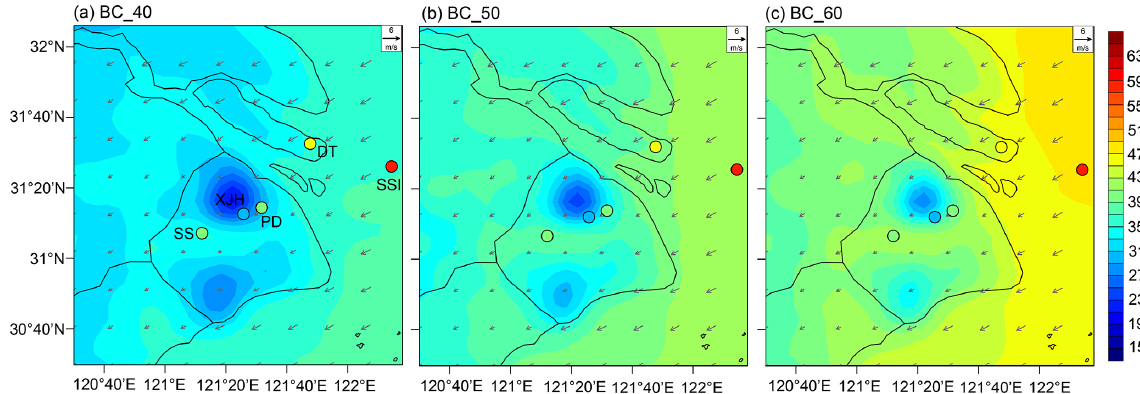
Figure 8. Calculated distributions of monthly mean O 3 concentrations (shades,ppbv) from BC_40, BC_50 and BC_60 simulations, respec- tively, in September 2014. Model results are compared with observed mean O 3 concentrations (circles, ppbv) obtained from the Sheshan (SS), Xujiahui (XJH), Pudong (PD), DT (Dongtan) and Sheshan Island (SSI) sites. Also shown is the calculated wind field (ms − 1 ) averaged over the same